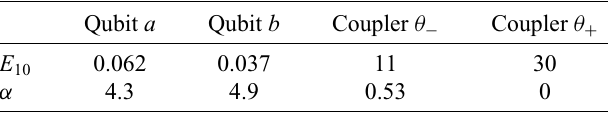
TABLE II. The energy splittings and anharmonicities of the bare modes. The fluxonium qubits are biased at their half-flux sweet spots, while the coupler θ − mode is biased at (cid:3) c /(cid:3) 0 = 0.27. The energy splittings are differences between the bare ground and first-excited-state energies E 10 = E 1 − E 0 , while the anharmonicity is defined as α = E 21 − E 10 . All quantities are in units of h GHz.